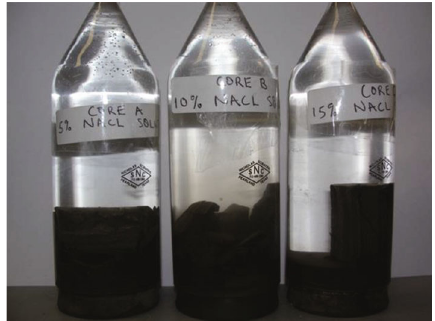
Figure 3: Imbibition tests from Morsy and Sheng